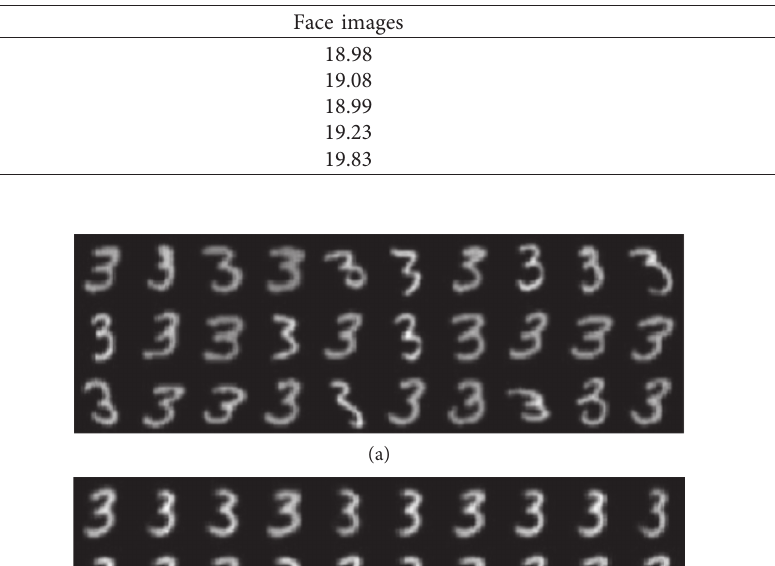
Figure 1: Comparison of algorithms in recovering images. (a) Original; (b) RASL; (c) NQLSD; (d) PSSV; (e) MRASL; (f) ours. Table 1: Results of mean peak signal-to-noise